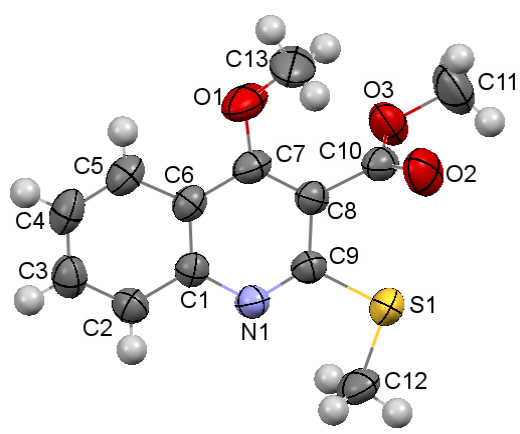
Figure 7. Molecular structure of compound 4 according to X-ray diffraction data. Thermal displacement ellipsoids are shown at the 50% probability level.